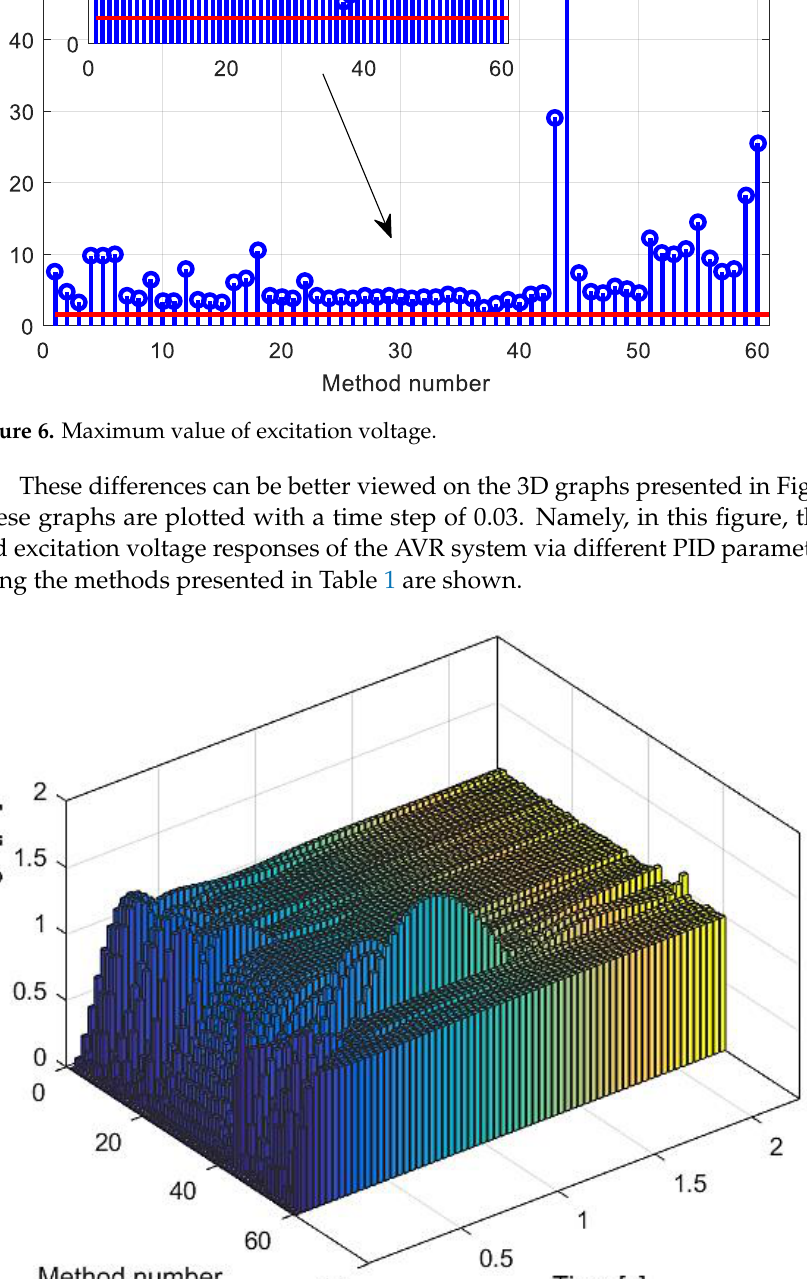
Figure 7. Generator voltage responses of the AVR system via different PID parameters.